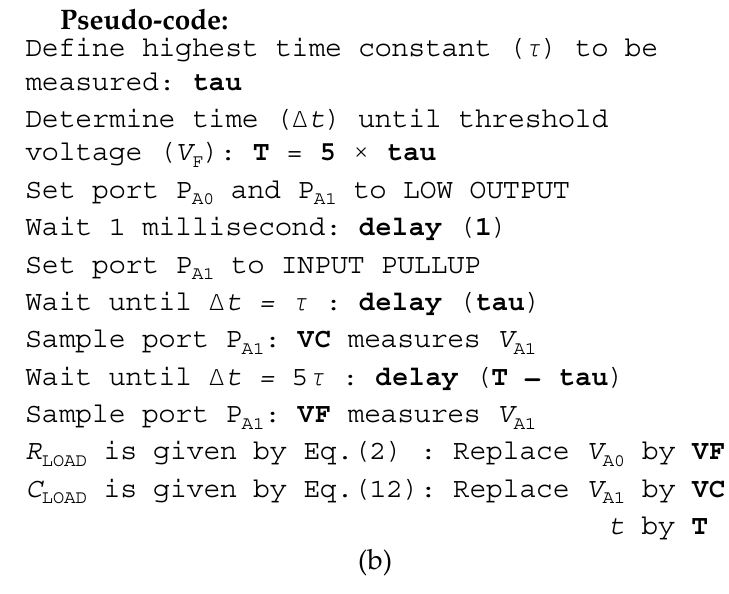
Figure 6. Set-up for recording a load impedance ( Z LOAD ) formed by a parallel RC network. ( a ) Illustration of the transient response to a voltage step at the input terminal (P A0 ). ( b ) Pseudo-code used to implement the measurement of a parallel RC network.